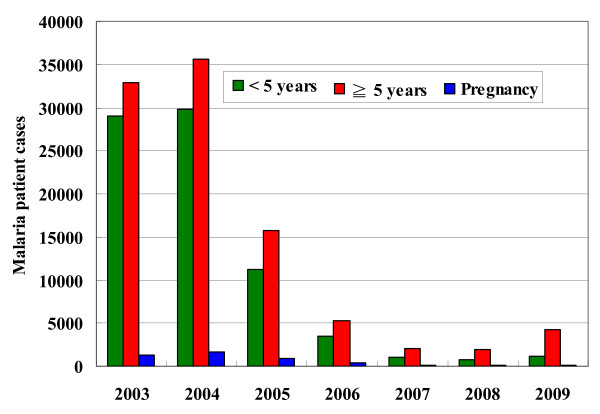
Malaria morbidity on the island of São Tomé 2003-2009.